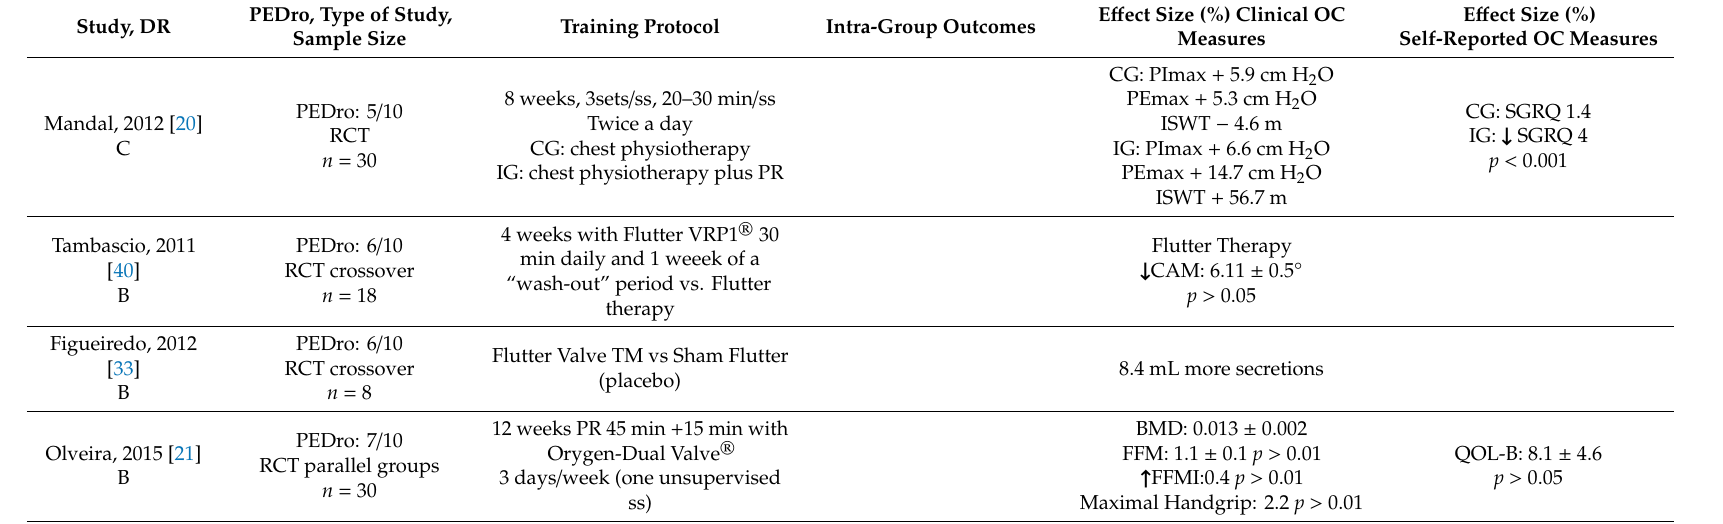
FFM: 1.1 ± 0.1 p > 0.01 ↑ FFMI:0.4 p > 0.01 Maximal Handgrip: 2.2 p > 0.01